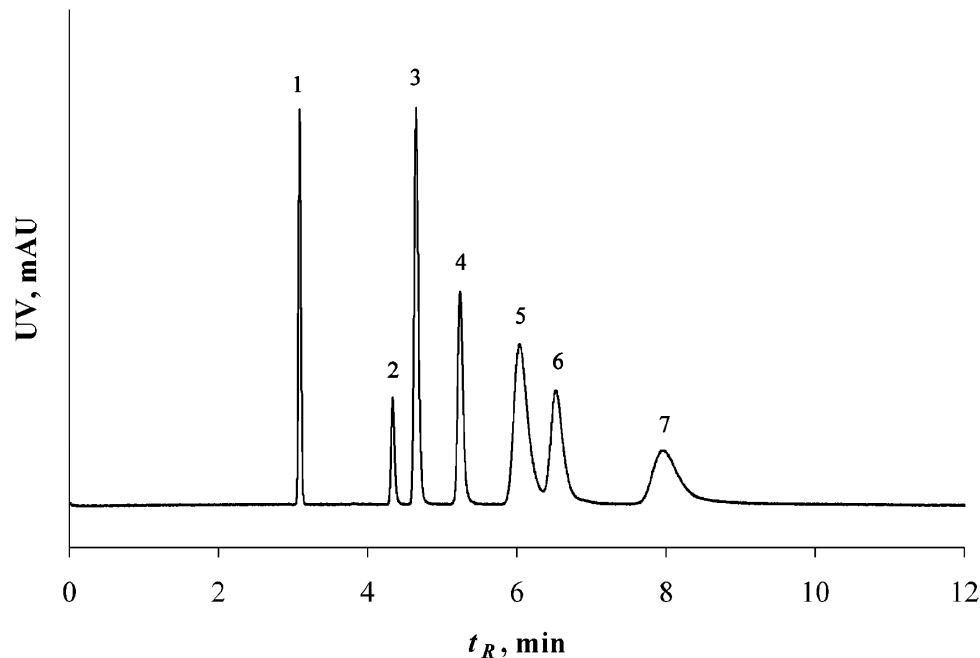
Figure 10. Chromatogram showing separation of a mixture of PAH compounds, on low density methacrylate monolith. Key: (1) thiourea; (2) naphthalene; (3) fluorine; (4) anthracene; (5) pyrene; (6) benz(a)anthracene; and (7) benzo(a)pyrene. Reprinted with permission from [35], Copyright (2005) American Chemical Society.